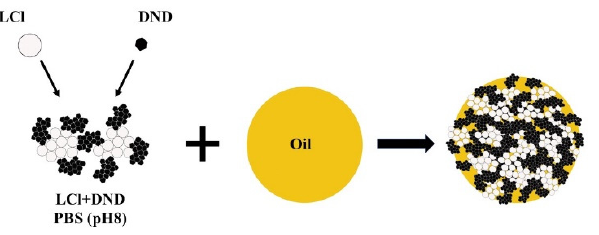
Figure 4. Scheme of stabilization of the direct emulsion by the LCl/DND mixture.